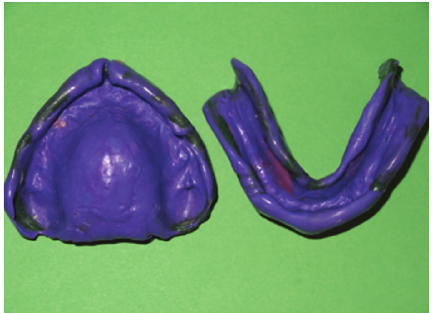
Figure 2: Maxillary and mandibular final impression made using elastomeric impression